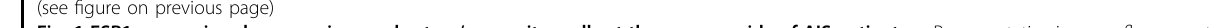
Fig. 1 ESR1 expression decreases in muscle stem/progenitor cells at the concave side of AIS patients. a Representative immuno fl uorescent staining of bilateral para-spinal muscle sections from an AIS patient. Cryosections were obtained from the convex and concave sides of AIS patients. The cryosections were stained with anti-Laminin antibody. Red indicated laminin; Blue indicated DAPI staining of nuclei. The merged images were shown. Scale bars: 100 μ m. b Statistical analysis of the cross-sectional area (CSA) of myo fi bers. At least 350 fi bers were analyzed for each sample. Error bars indicated standard deviation ( n = 6). ** P < 0.01. c Muscle tissues harvested from the concave and convex side of AIS patients were subjected for scRNA-seq. Samples from two patients were used. Total 16,930 cells were analyzed. The UMAP plots of main cell types for muscles originated from concave and convex side were shown. FAPs indicated fi bro/adipogenic progenitors; ECs indicated epithelia cells; SMCs indicated smooth muscle cells; MuSCs/progenitors indicated muscle stem/progenitor cells. d Dot plot of highly expressed genes in each cell type. The size of dots indicated the percentage of cells expressing the designated genes. The color of dots represented gene expression level. e Violin plot of highly expressed genes in each cell type. f Percentage of each cell type at the concave and convex side. g UMAP plots of genes marked muscle stem/progenitor cells. h Pathway enrichment analysis of differentially expressed genes in muscle stem/progenitor cells located at the concave and convex side of AIS patients. Red bars indicated the enriched terms up-regulated in muscle stem/progenitor cells located at the concave side. Blue bars indicated the enriched terms down-regulated in muscle stem/progenitor cells located at the concave side. The enriched terms related to myogenesis were highlighted by the red solid frames and the terms related to estrogen signaling were highlighted by the red dashed frames. i Dot graph of ESR1 and ESR2 expression in each cell types identi fi ed in muscle located at the concave and convex side of AIS patients, respectively. j RT-qPCR analysis of ESR1 and ESR2 gene expression levels in muscle stem/progenitor cells isolated from para-spinal muscles derived from non-scoliosis (NS, n = 5), congenital scoliosis (CS, n = 8) and adolescent idiopathic scoliosis (AIS, n = 25) patients. Error bars indicated standard deviation. ** P < 0.01; ns indicated no signi fi cant changes. k ELISA analysis of ESR1 level in muscle stem/progenitor cells isolated from para-spinal muscles derived from non-scoliosis (NS, n = 5), congenital scoliosis (CS, n = 8) and adolescent idiopathic scoliosis (AIS, n = 25) patients. Error bars indicated standard deviation. ** P < 0.01; ns indicated no signi fi cant